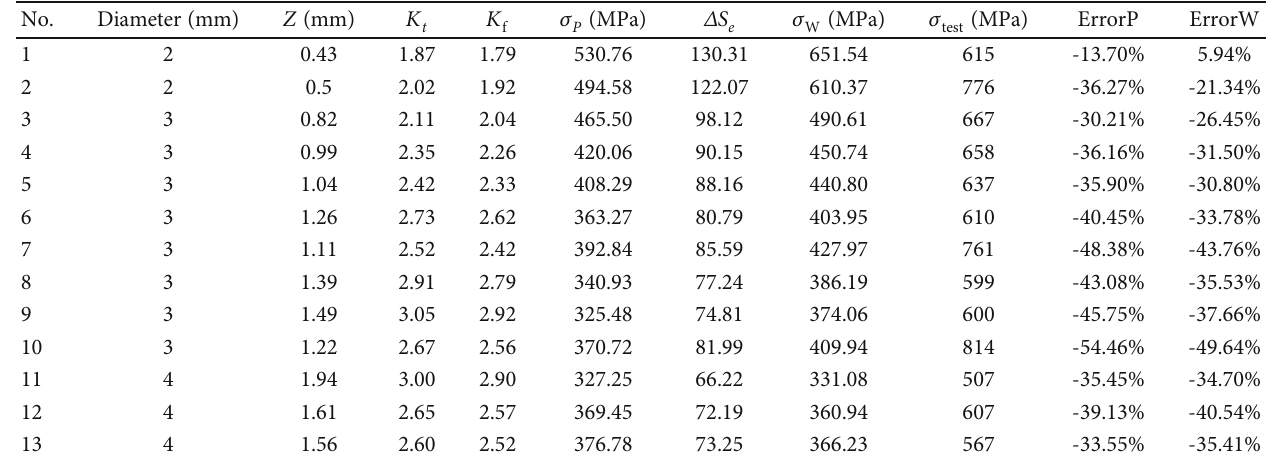
Table 4: Fatigue limit predictions by Peterson formula and WCN model.